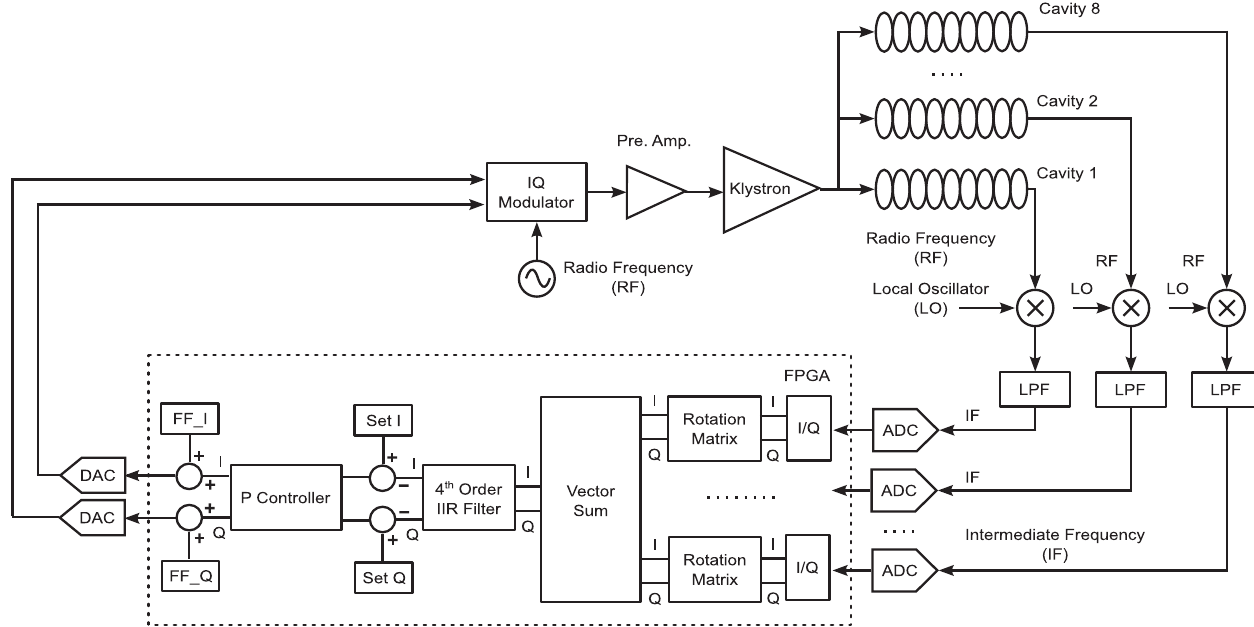
FIG. 2. Simplified diagram of digital LLRF feedback loop controlling eight superconducting cavities.